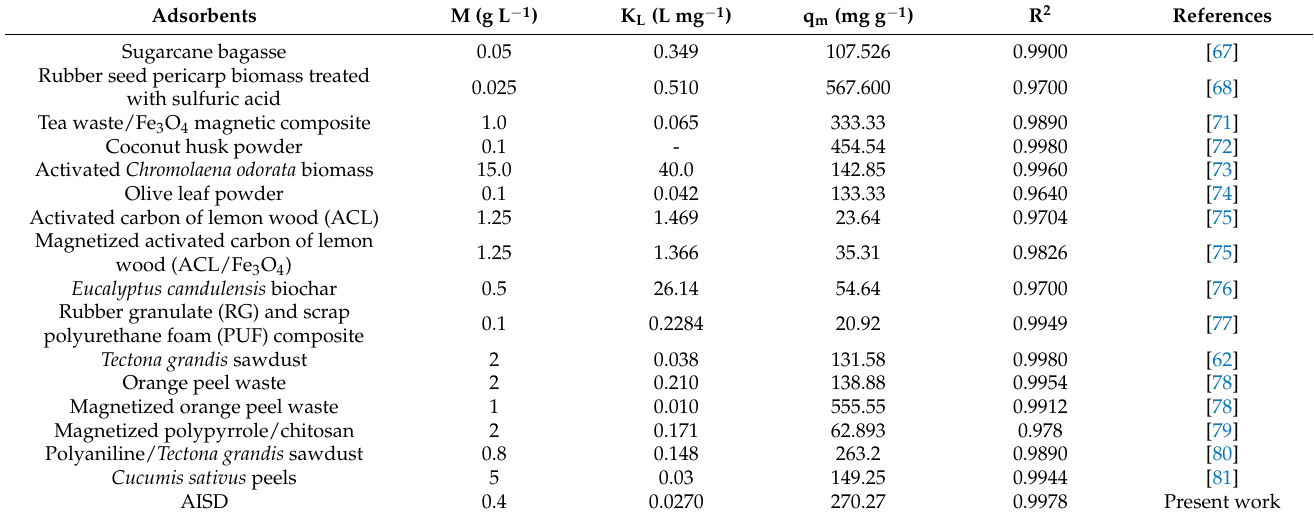
Table 4. LR isotherm parameters for adsorption of CV onto different